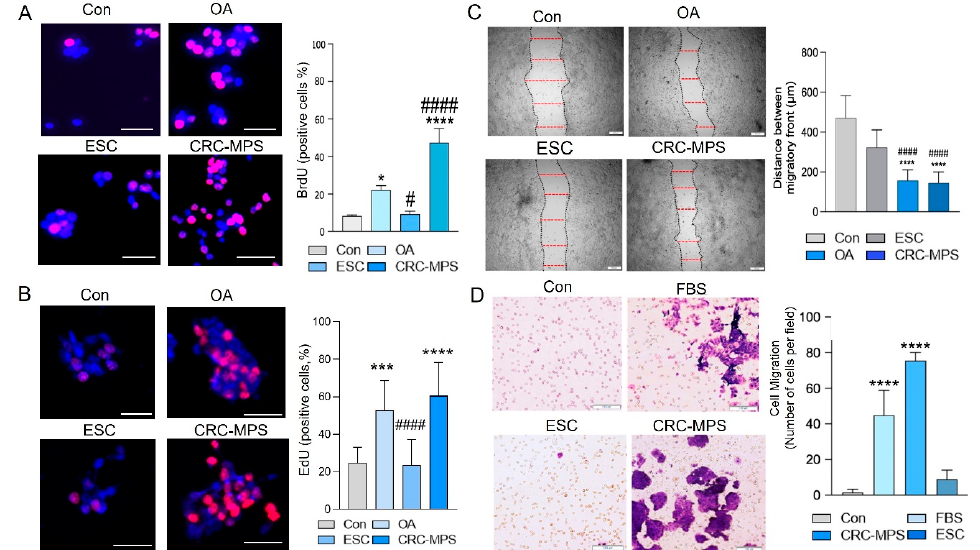
Figure 2. ( A ) Representative images and quantification of BrdU incorporation during DNA synthesis in HT29 cells treated with conditioned media (CM) from CRC-MPS (obese) vs. CM from ESC. Oleic acid (OA) treatment represents positive control and serum-free media (Con) represents negative control (24 h, n = 3, **** p < 0.0001, * p < 0.05 vs. Con; #### p < 0.0001, # p < 0.05 vs. OA, scale bar = 50 µ m). ( B ) Representative images and quantification of EdU incorporation during DNA syn- thesis in HCT116 cells treated with CM from CRC-MPS (obese) vs. CM from ESC. Oleic acid (OA) treatment represents positive control and serum-free media (Con) represents negative control (24 h, n = 3 wells in 2 independent experiments, **** p < 0.0001, *** p < 0.001 vs. Con; #### p < 0.0001 vs. OA, scale bar = 50 µ m). ( C ) Representative images and quantification of confluency disruption of HT29 monolayers via scratch assay (24 h, n = 3, **** p < 0.0001 vs. Con; #### p < 0.0001 vs. ESC, scale bar 200 = µ m). ( D ) Transwell migration assay of HCT116 cells, with CM from CRC-MPS (obese),